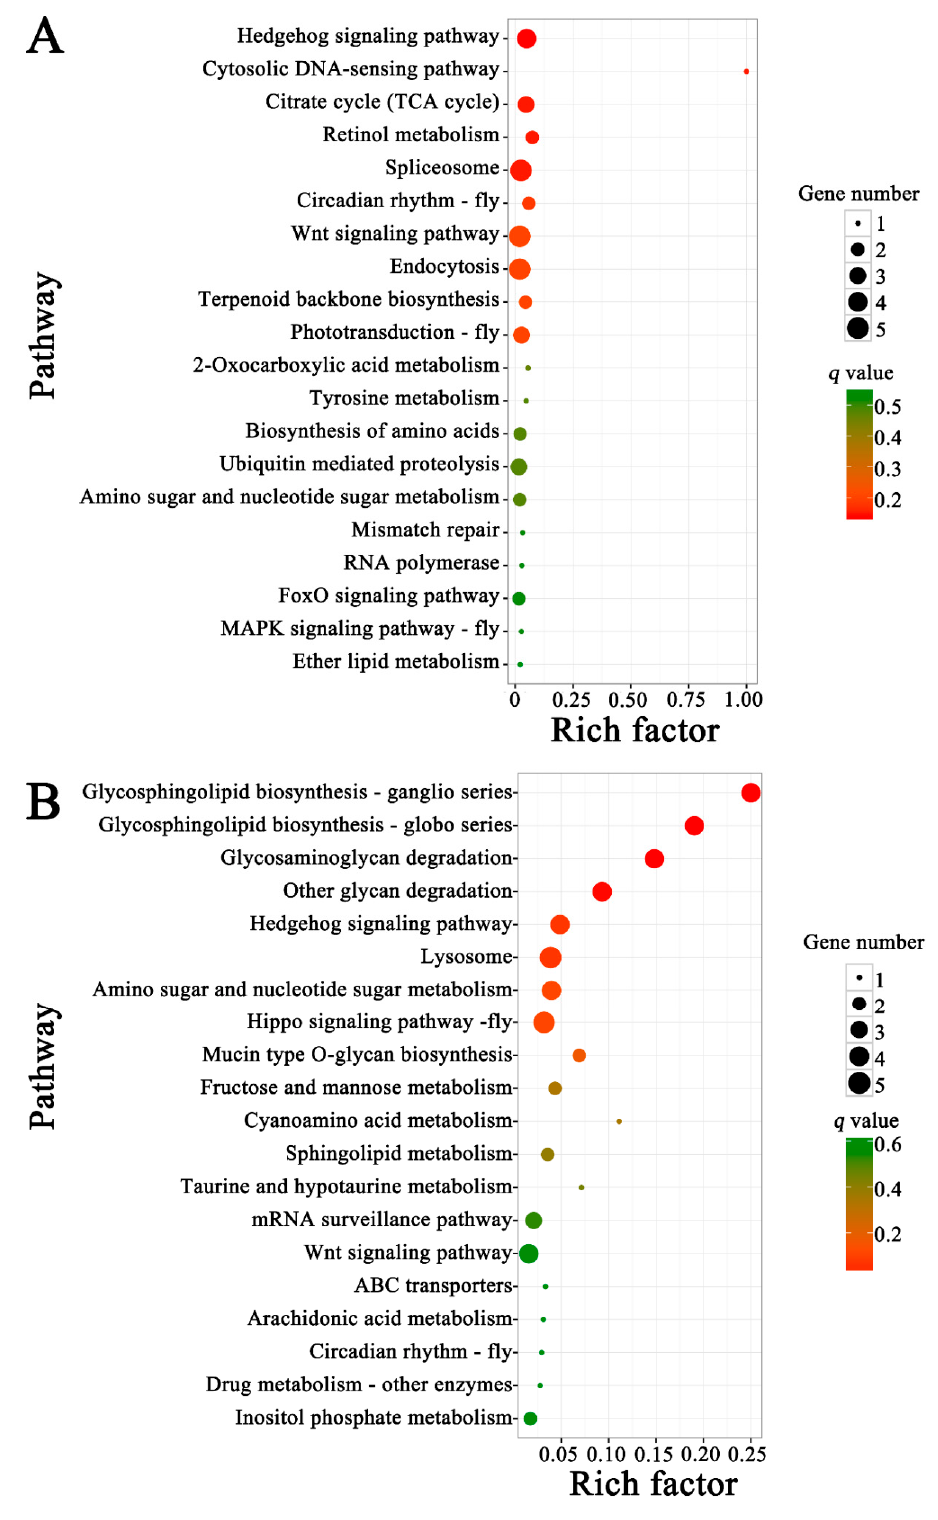
Figure 7. Kyoto Encyclopedia of Genes and Genomes (KEGG) pathway enrichment analyses of target genes of DElncRNA-targeted miRNAs in Am7CK vs. Am7T ( A ) and Am10CK vs. Am10T ( B ).